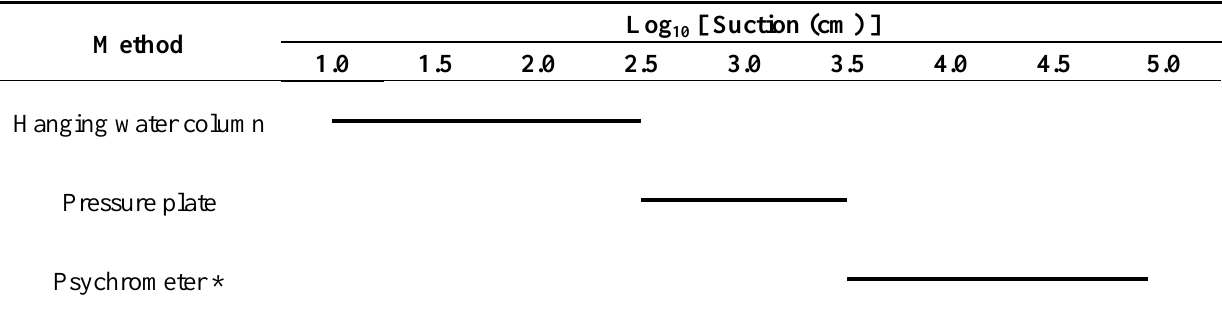
Table 1. Experimental procedures used for VWC measurements at selected soil suction